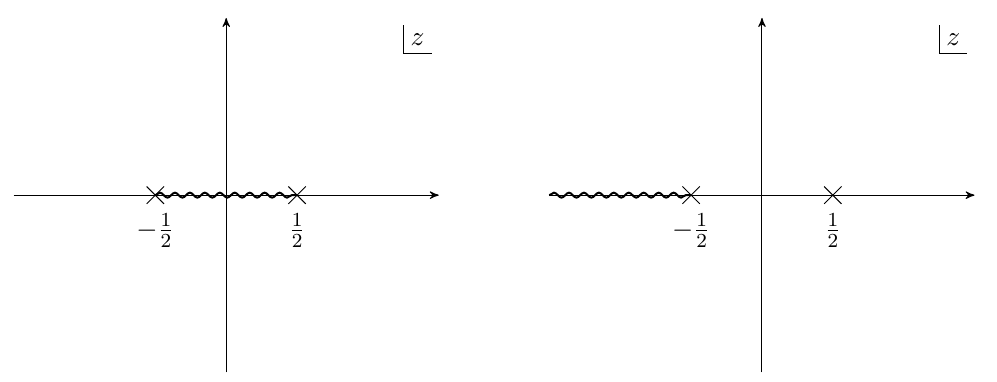
Figure 2 . Analytic structure of g i ( n; z ) (left) and g b (2 n; z ) (right) for positive integer n